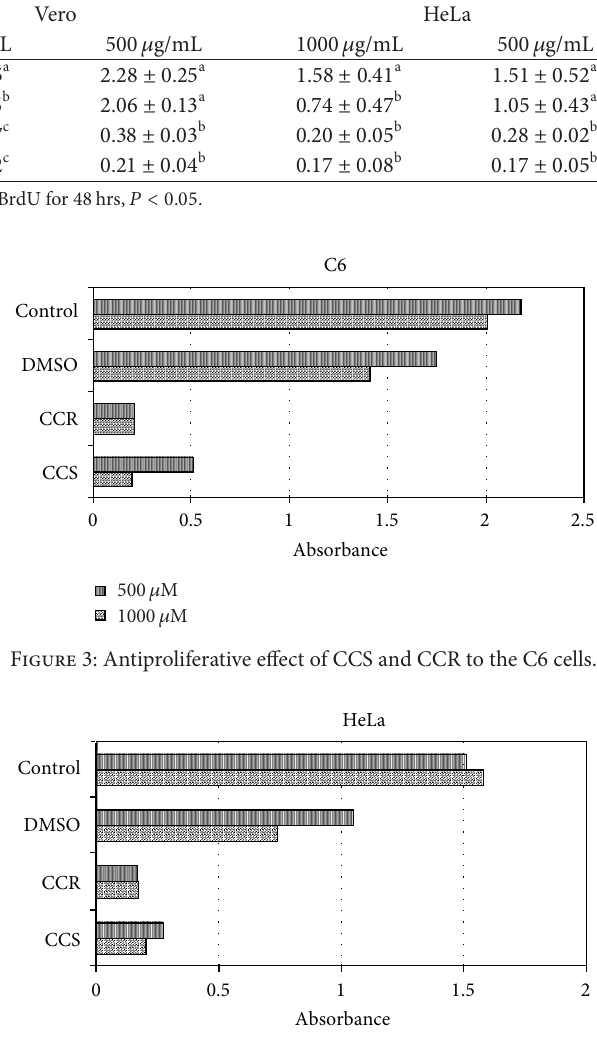
T 2: e antiproliferative effect of hexane extract of C. carduiformis in C6, Vero, and HeLa cells